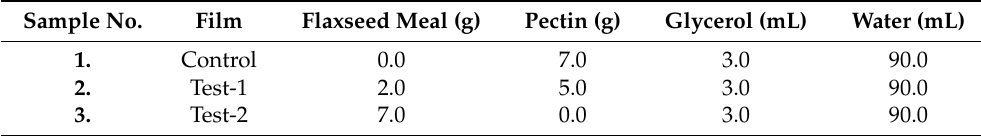
Table 1. Casting composition of films. Sample